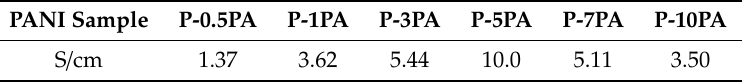
Table 2. Electrical conductivity (DC) of P-0.5PA to P-10PA at 25 ◦